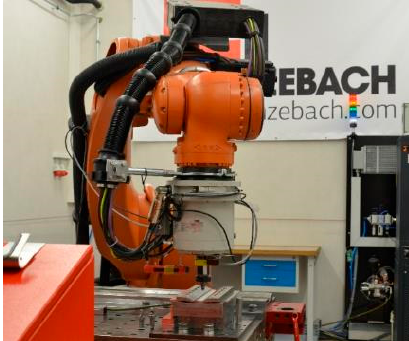
Figure 2. Robotized FSW setup and clamping structure.